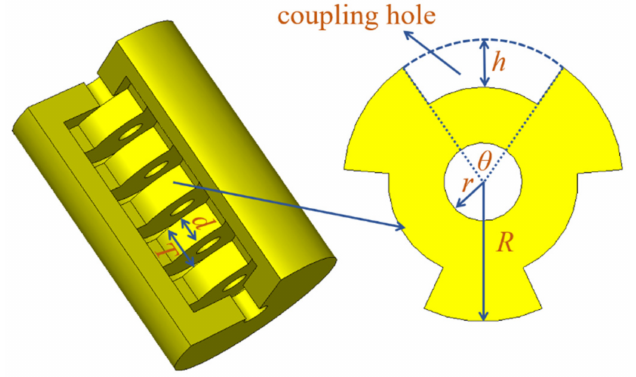
Figure 1. Schematic of the three-hole coupling cavity and disk in the